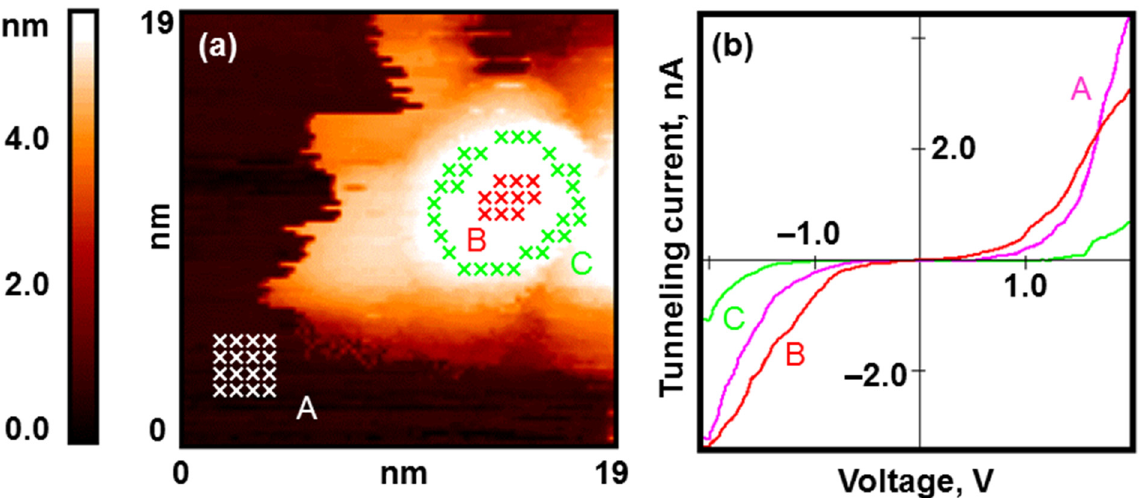
Figure 9. Oxidized platinum nanoparticles after exposure to H 2 (200 L). Results of the STM/STS measurement: ( a ) topography image of the HOPG surface with deposited platinum nanoparticle with points of spectroscopy measurements marked with crosses; ( b ) VAC curves of the tunneling currents averaged over the set of points on the surface of HOPG (pink curve A), central (red curve B), and peripheral (green curve C) areas of the nanoparticle marked in ( a ).